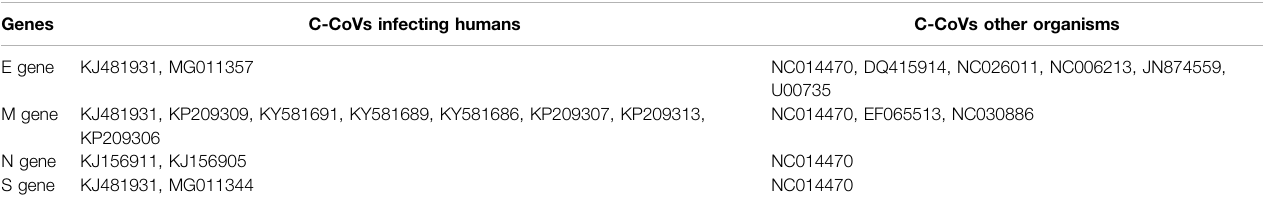
TABLE 2 | Analysis of structural gene sequences of common coronaviruses (C-CoVs) evolutionarily related to severe acute respiratory syndrome coronavirus-2 (SARS- CoV-2). Genes C-CoVs infecting humans C-CoVs other organisms E